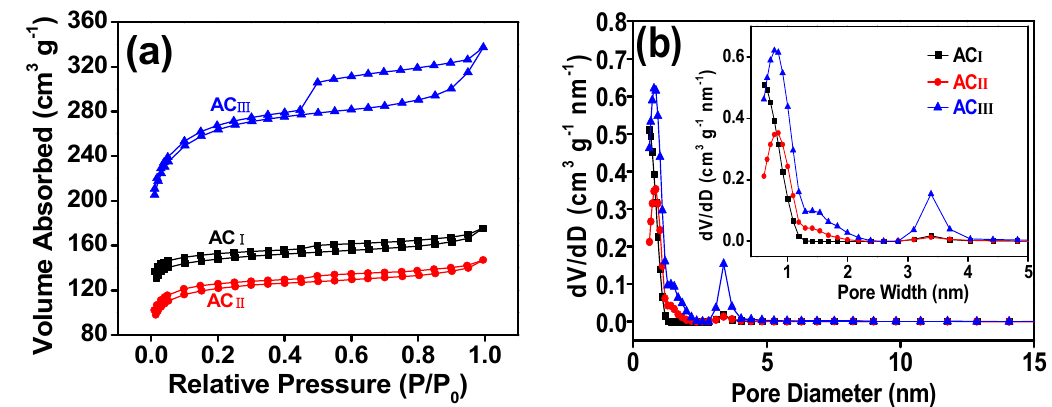
Figure 5. N 2 adsorption-desorption isotherms ( a ) and pore size distribution ( b ) of AC I , AC II and AC III .